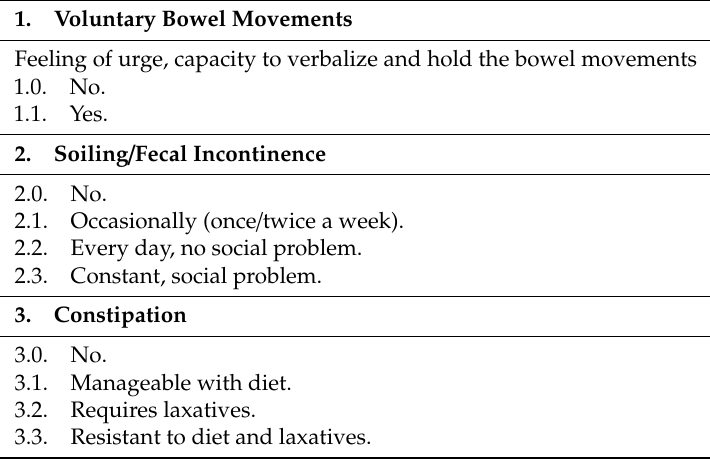
Table 1. International classification (Krickenbeck) for postoperative